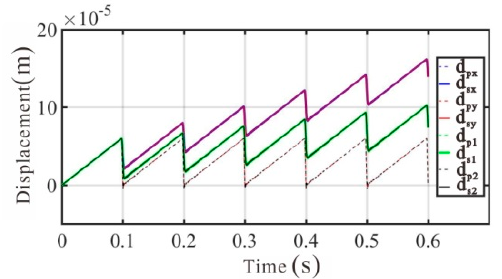
Figure 6. Results of two directions in the 2-DOF PIDM and the two 1-DOF PIDMs driven at the same driving signal.